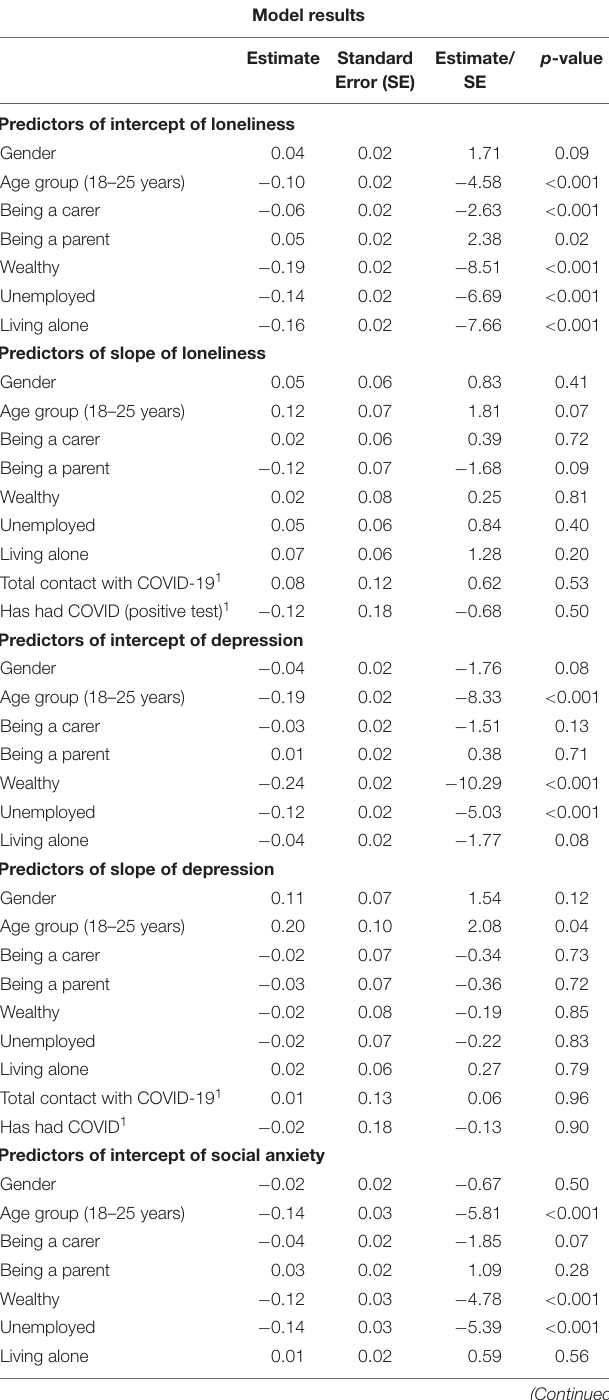
TABLE 3 | Parameter estimates for Model 1b: predicting associations between time points ( Supplementary Tables 9, 10 ) as we did for change in loneliness, depression, social anxiety, and SARS-CoV-2 our full subsample where missing data were accounted for social restrictions. using MLR. Model results Estimate Standard Estimate/ p -value error (SE) SE TABLE 4 | Parameter estimates for Model 1b: demographic predictors of change in loneliness, depression, and social